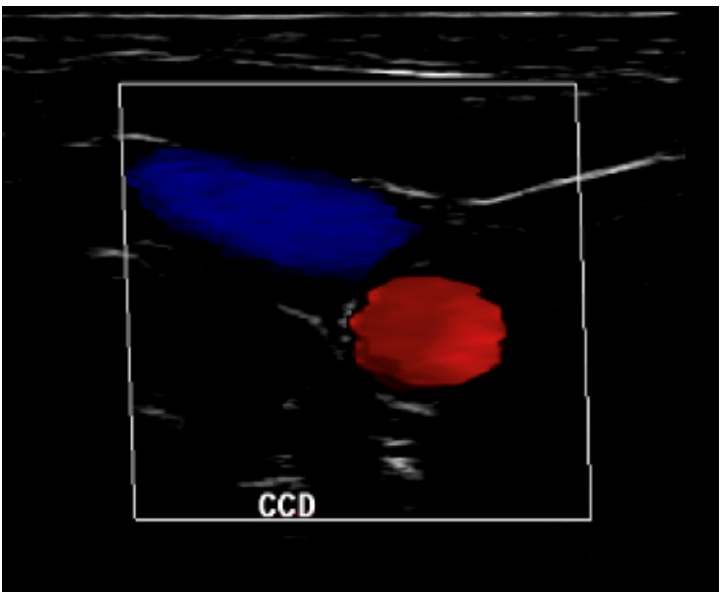
Figure 2. A manual internal jugular vein (blue) compression was performed for 60 s to elevate ICP with the aid of ultrasound to avoid compressing common carotid artery (red).